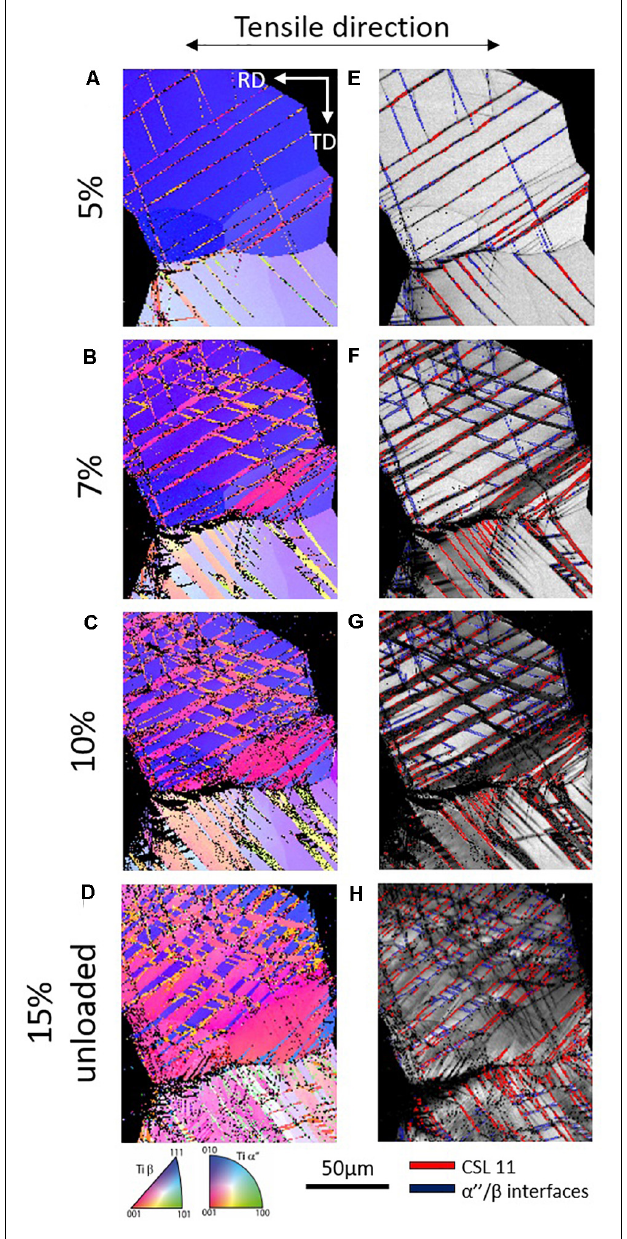
FIGURE 5 | In situ follow of the deformation in Ti–12Mo. (A–D) Electron backscatter diffraction IPF images along the normal direction at 5, 7, 10, and 15% after unloaded (surface slightly electropolished) and (E–H) corresponding image qualities. Bands in red correspond to a 50.5 ◦ < 110 > misorientation (CSL (cid:54) 11) equivalent to {332} < 113 > twins and bands in blue to α (cid:48)(cid:48) / β matrix